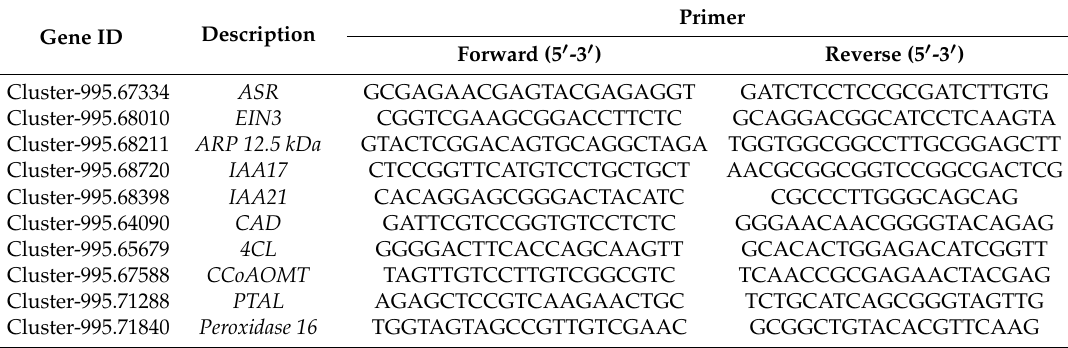
Table 1. Primers for quantitative PCR validation of the RNA-seq data.